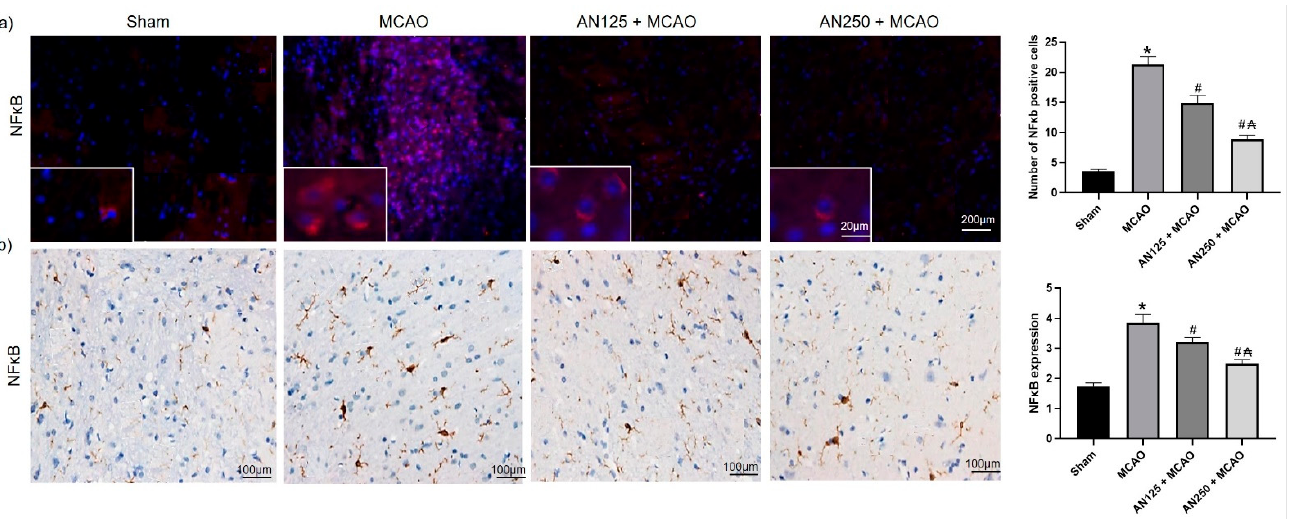
Figure 6. The impact of pretreatment with anethole (AN, 125, 250 mg/kg, orally) for two weeks in MCAO-induced cerebral ischemia/reperfusion in rats on NF- κ B/p65 ( a ) immunofluorescence (red cells represent NF- κ B/p65) and ( b ) immunohistochemical staining (×400). Data are expressed as mean ± SD ( n = 6). * significantly different from the sham-operated group, # significantly different from the MCAO ischemic group, and ₳ significantly different from the AN125 + MCAO group at p < 0.05 using ANOVA followed by Tukey’s post hoc test.